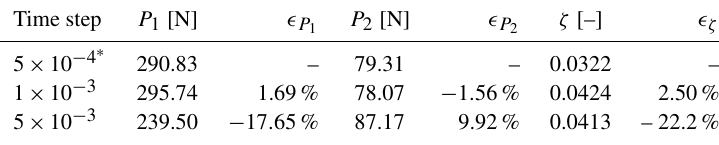
Table A2. Comparison of peaks and damping ratios for different time steps.